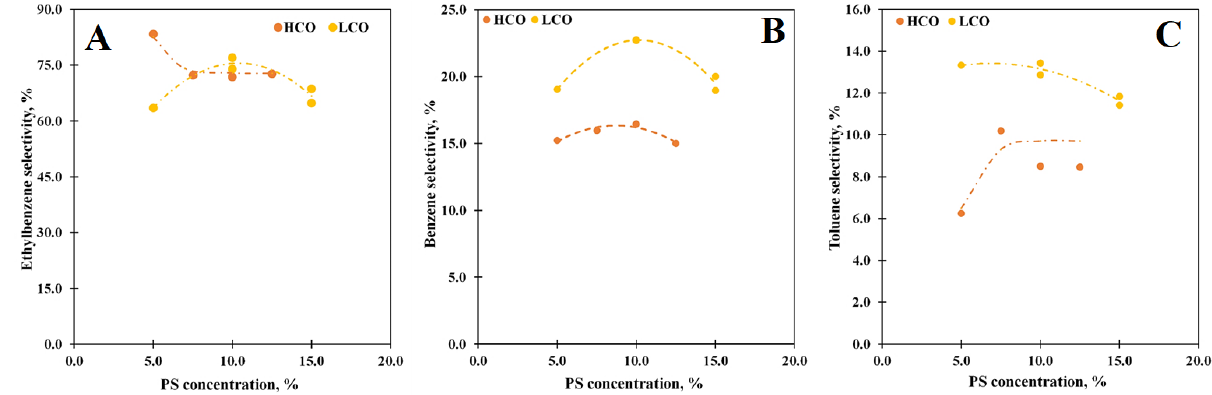
Figure 8. The ethylbenzene ( A ), benzene ( B ), and toluene ( C ) selectivity vs. the PS concentration at 550 °C and WHSV 85 h − 1 . 550 ◦ C and WHSV 85 h − 1